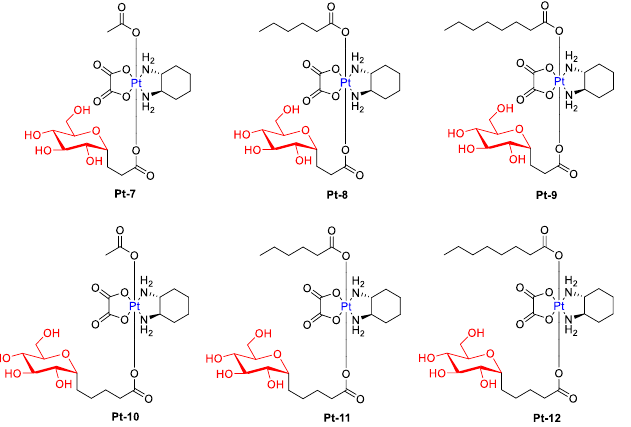
Figure 5. Chemical structures of glycosylated Pt(IV) complexes with different linkers (Pt-7 – Pt-12).